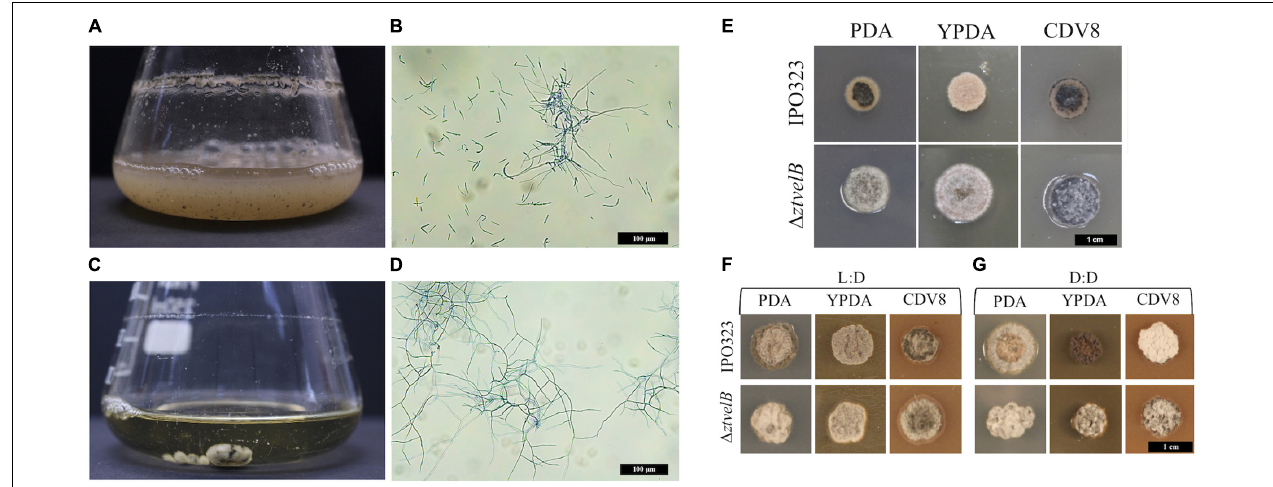
FIGURE 2 | Comparison of vegetative growth of the Z. tritici IPO323 and the (cid:49) ztvelB mutant strains. Images representative of three independent (cid:49) ztvelB strains tested across three independent experiments. (A–D) Z. tritici IPO323 strain and (cid:49) ztvelB mutant growth in PDB at 20 ◦ C on a rotary shaker at 200 rpm, 7 days post-inoculation (dpi) stained with lactophenol cotton blue. (A,B) The IPO323 strain forms a cloudy suspension composed of short yeast-like cells and branched hyphal cells. (C,D) The (cid:49) ztvelB mutants form mycelial clumps composed of branched hyphal cells and no yeast-like cells. (E) IPO323 and (cid:49) ztvelB mutant growth on solid media at 20 ◦ C under LD conditions, at 7 dpi. The IPO323 strain grows as yeast-like cells which melanise on PDA and CDV8. The (cid:49) ztvelB mutants only grow as grey and white aerial hyphae from a melanised base. (F) IPO323 and (cid:49) ztvelB mutant growth under LD or DD conditions at 10 dpi. Under LD, the IPO323 colonies melanise and produce grey and white aerial hyphae by 10 dpi. (G) Under DD the IPO323 strain melanises and forms grey aerial hyphae on PDA. On YPDA, DD colonies produce fewer aerial hyphae than under LD. On CDV8, DD colonies produce more white aerial hyphae than under LD. In contrast, the (cid:49) ztvelB mutant only grow as grey and white aerial hyphae which are phenotypically similar under both LD and DD conditions.